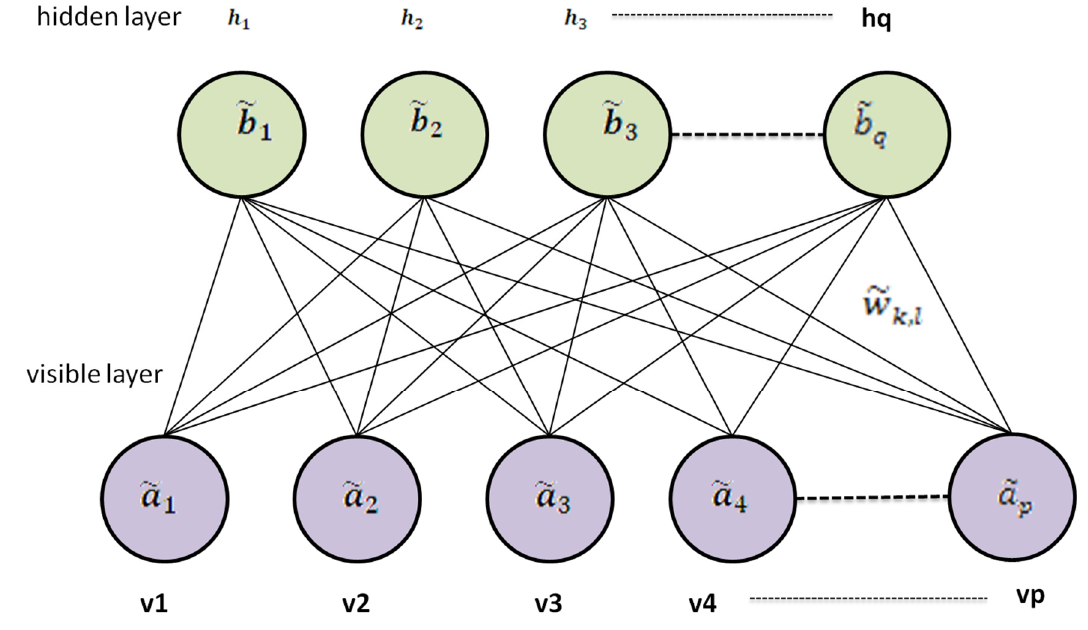
Figure 3. Structure of FRBM [Source: